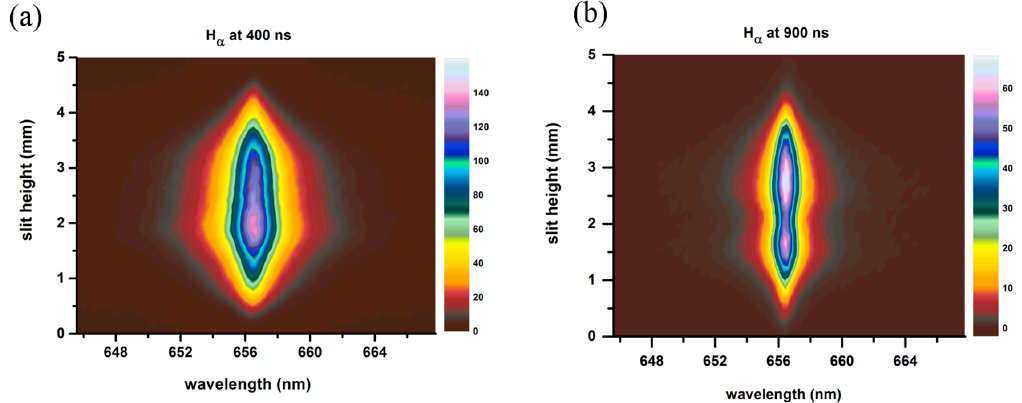
Figure 2. Hydrogen alpha plasma spectra images at time delays of ( a ) 400 ns and ( b ) 900 ns.